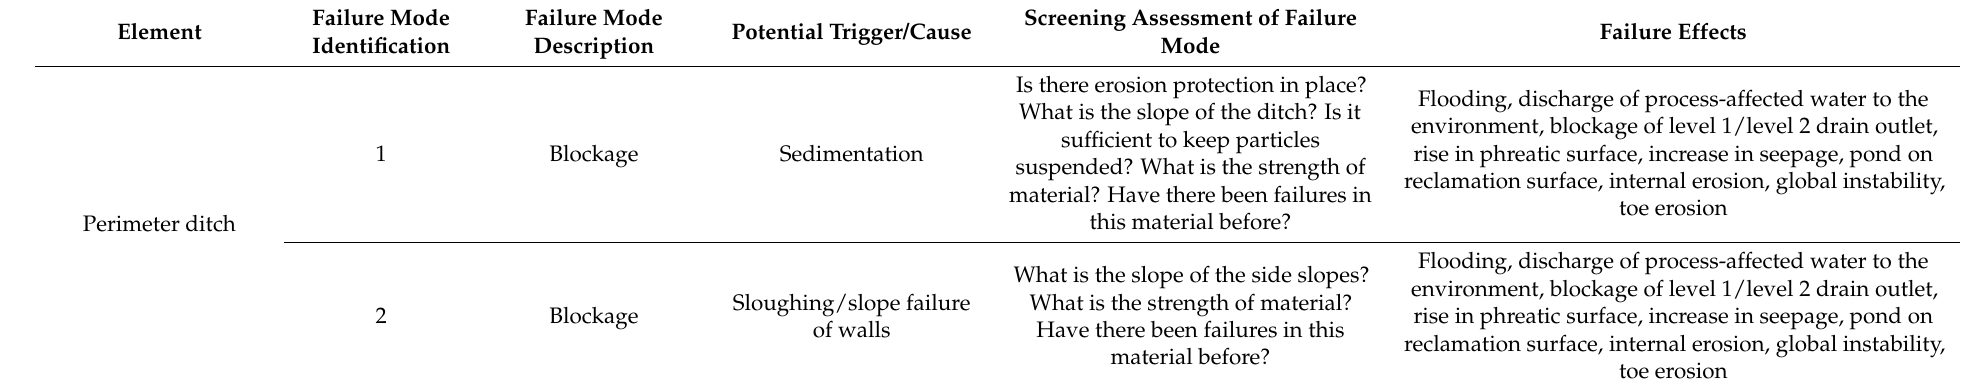
Table A2. Application of G-FMEA to a case study